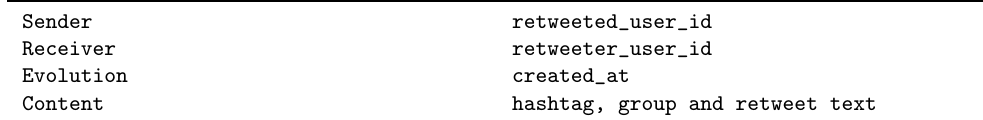
Table 3. Structured network retweet